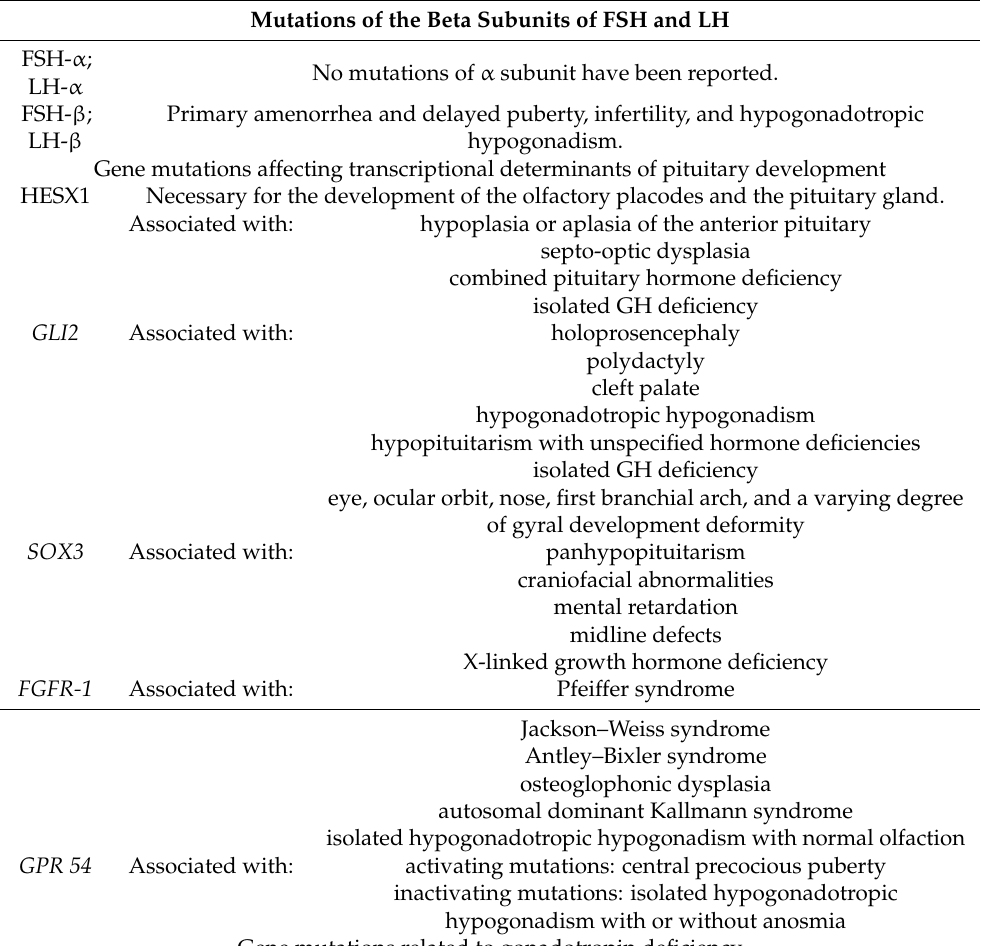
Table 1. Summary of mutations contributing to hypogonadotropic hypogonadism. Mutations of the Beta Subunits of FSH and